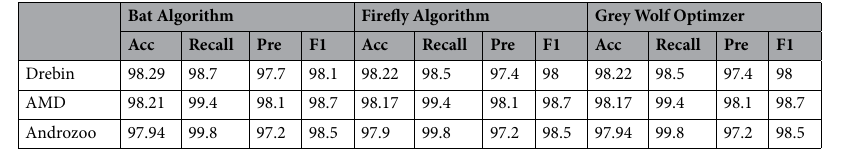
Table 9. Results of